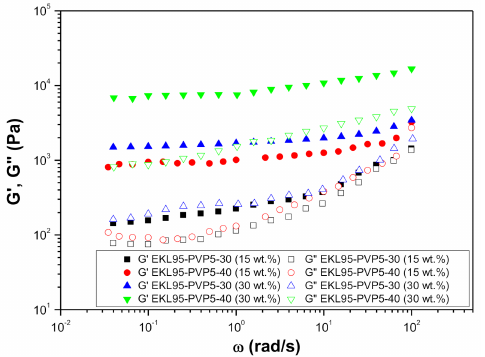
Figure 7. Evolution of the linear viscoelastic functions with frequency for oleogels prepared with EKL/PVP electrospun nanofibers (applied stress: 1–3 Pa, depending on the consistency of the